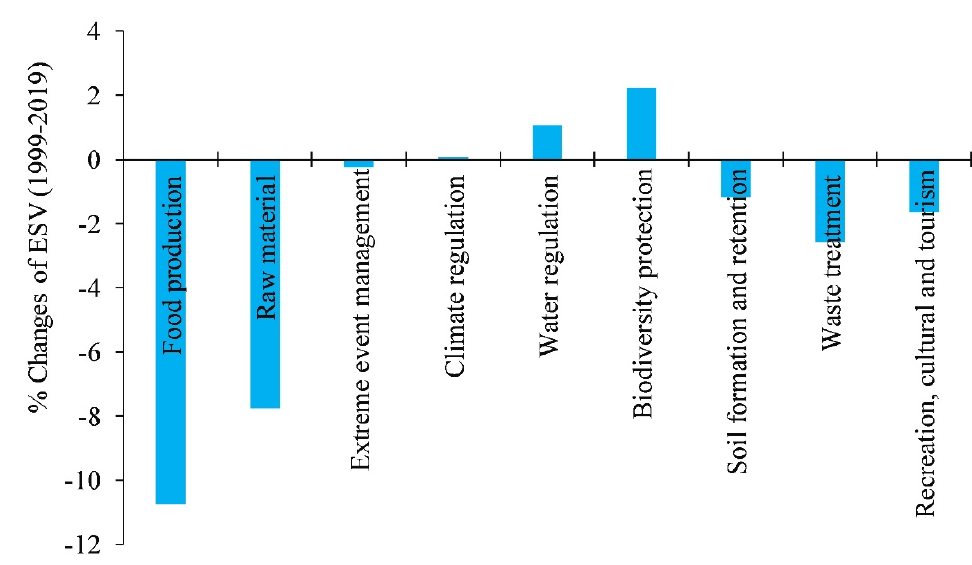
Figure 5. Changes in the values of different ES functions in coastal Bangladesh during 1999–2019.